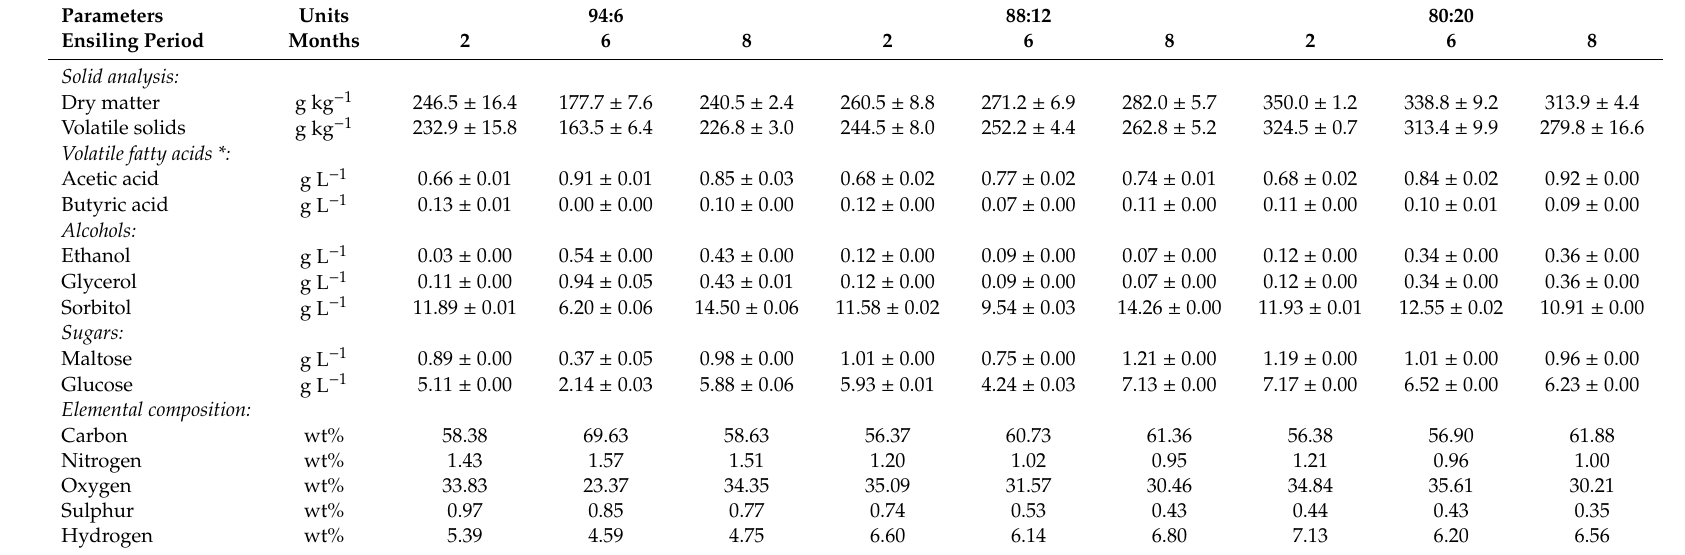
Table 2. Characterization of co-ensiled substrates with a mixing ratio (WW) of sugar beet root and wheat straw at 94:6, 88:12 and 80:20 at di ff erent ensiling periods.